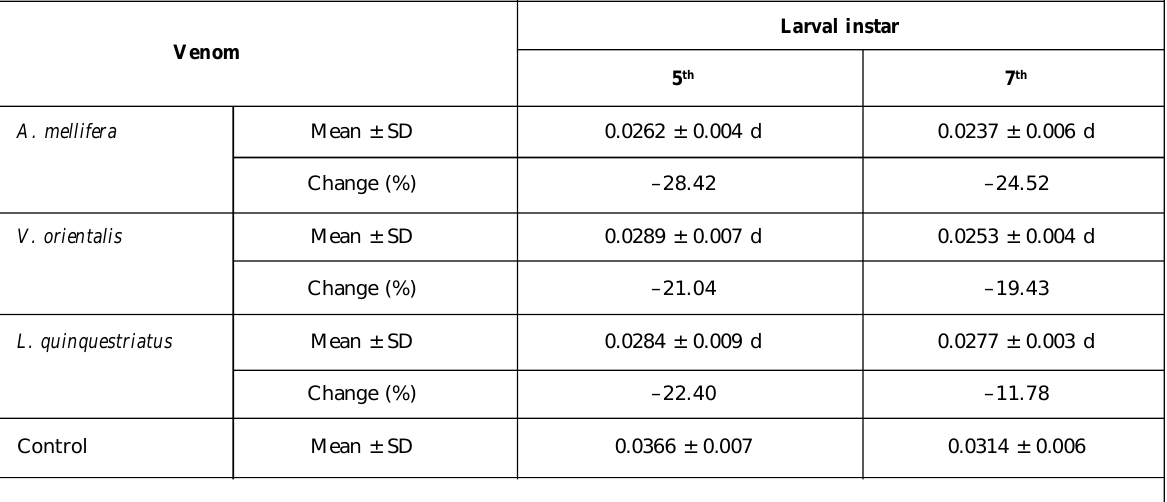
Table 5: Influenced total carbohydrate content (mg/g) in the larval tissues after treatment of the 3 rd instar larvae of G. mellonella with LC values of certain arthropod 50